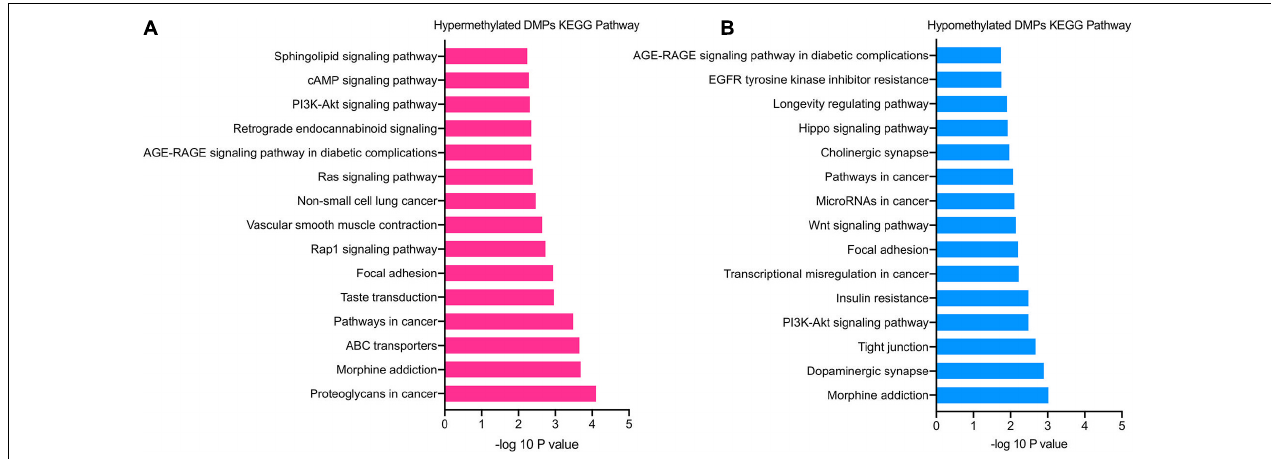
FIGURE 4 | KEGG pathway enrichment analysis of TAO-associated DMPs. (A) Top 15 enriched KEGG pathways of hypermethylated DMPs. (B) Top 15 enriched KEGG pathways of hypomethylated DMPs.